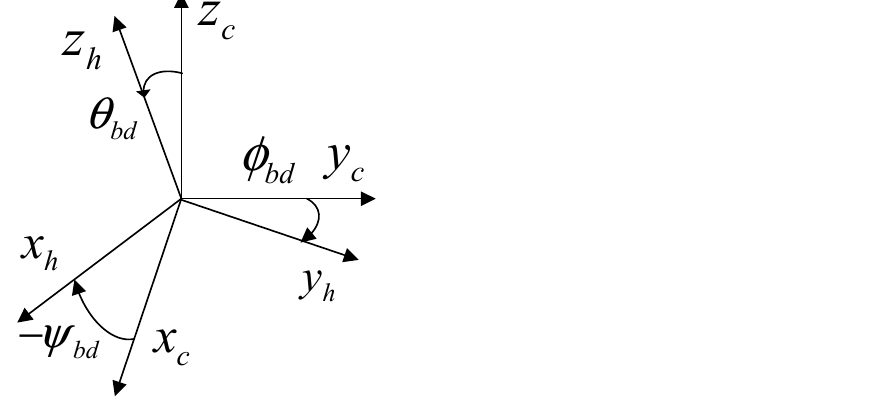
Figure 4. Relationship between the body coordinate fame, x h y h z h , and the camera-based coordinate frame, x c y c z c